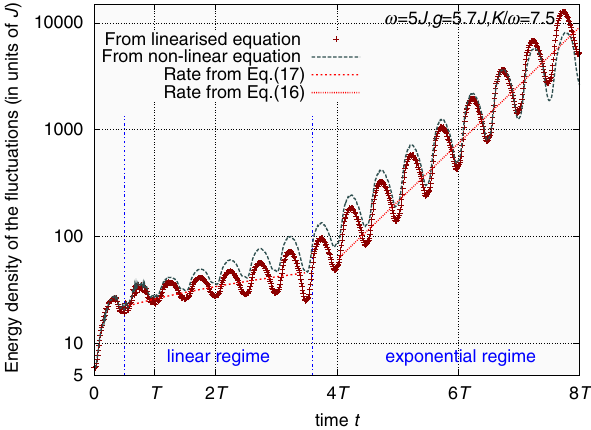
FIG. 6. Time evolution of the energy density of the fluctuations (in units of J ) over eight driving periods for the initial conditions 1 and B 0 (see text), for ω ¼ 5 J , K= ω ¼ 7 . 5 , and A q ¼ q ¼ g ¼ 5 . 7 . In this regime, where Γ is small, three regimes clearly show up: At very short times t ≪ T , the initial growth is not described by our Floquet approach, as previously explained; at intermediate times T ≪ t ≪ Γ − 1 , thegrowth is linear and described by Eq. (18) (red dotted line); at large times t ≫ Γ − 1 , the growth is exponential and described by Eq. (17) (red short-dotted